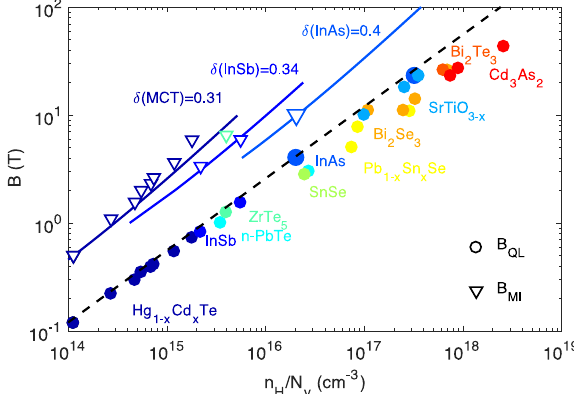
Fig. 4 Comparison of B QL and B MI in various doped semiconduc- tors. Observed metal – insulator transition fi elds (taken as the drop in the Hall carrier density), B MI (open triangles), and the positions of the last maximum in the resistivity or the Nernst effect, B QL ( fi lled circles) plotted as functions of the carrier densities of doped semiconduc- tors. The points are extracted from references 7,21,40 – 50 (see Supplementary Note 5). The dashed-black line is the predicted 2 3 B QL ¼ _ ð 3 π 2 n Þ for an isotropic parabolic dispersion with the g -factor e ð 1 þj M jÞ of InAs ( g (InAs) = 15, M = 0.13). The solid curves represent the metal – insulator transition fi eld vs. density calculated using Eq. (1) with δ = 0.31(Hg 0.8 Cd 2 Te), 0.34(InSb) and